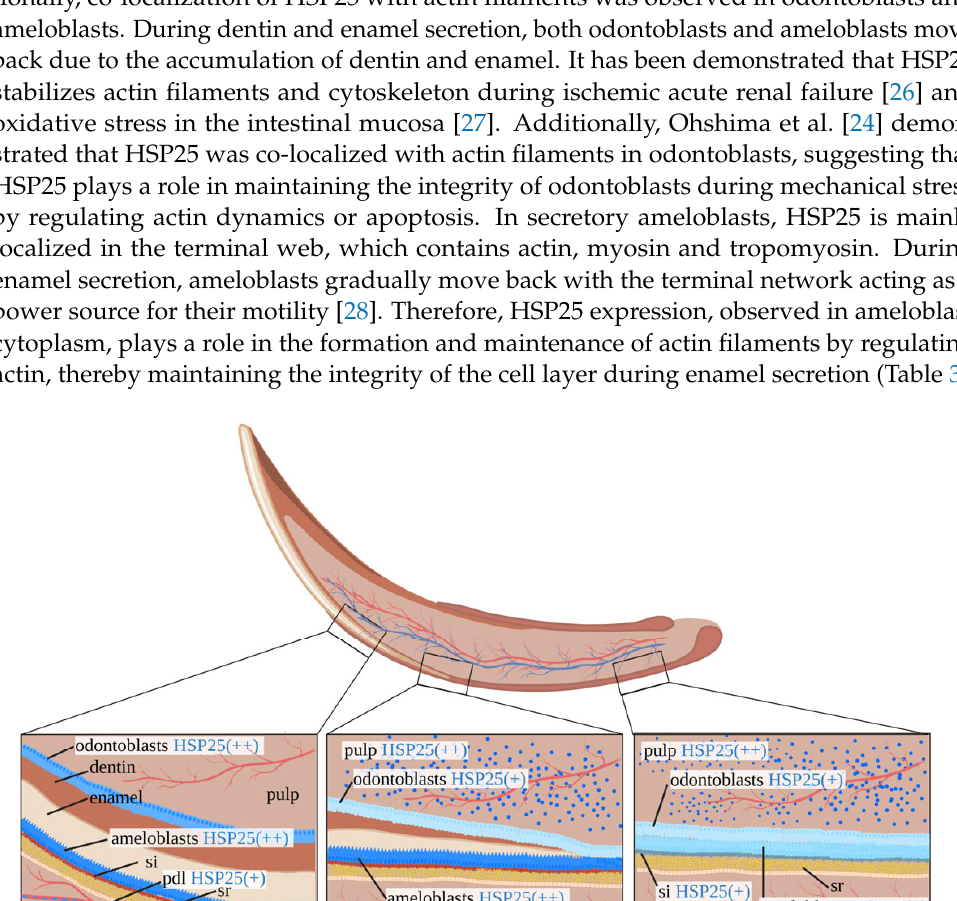
periodontal ligament. Subsequently, during the secretory stage of ameloblasts, HSP25 was strongly expressed in ameloblasts, while stratum intermedium cells became HSP25-negative, and the other cells’ HSP25 expression remained unchanged. At the mature stage of ameloblasts, strong HSP25 positivity was seen in ameloblasts and odontoblasts, along with some blood vessels in the periodontal ligament and mesenchymal cells in the odontoblast sublayer. HSP25